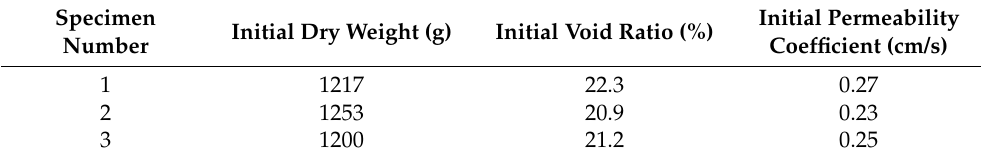
Table 7. Initial indicators of porous asphalt concrete (PAC)-graded Marshall specimens.